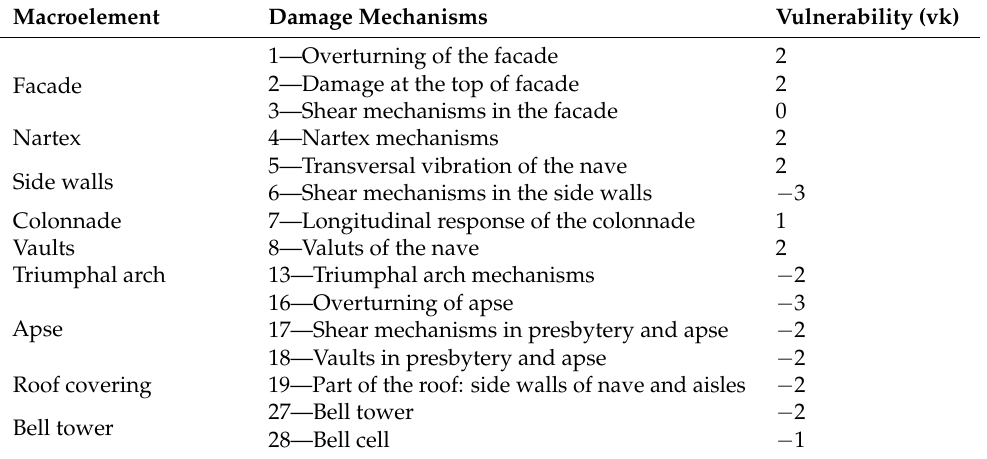
Table 4. Damage mechanisms associated with vulnerability score (vk) in the vulnerability indicator scorecard, highlighting of mechanisms with high vulnerability, ≥ 2.